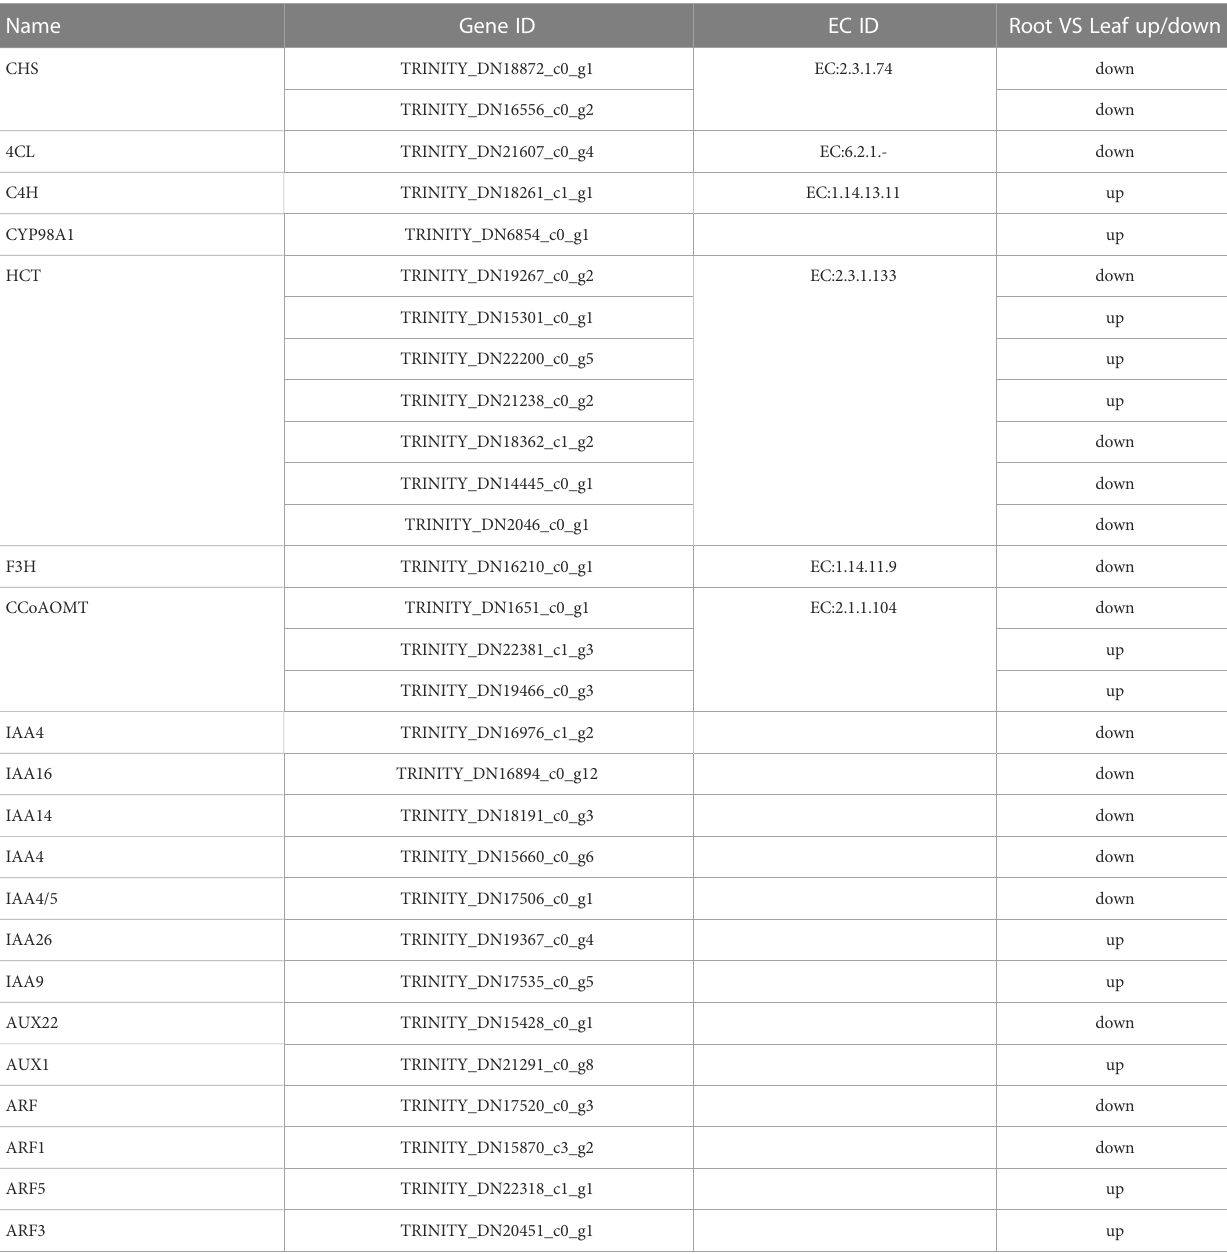
TABLE 2 Analysis of differentially expressed genes in plant hormone signal transduction, phenylpropanoid and fl avonoid biosynthetic pathways.